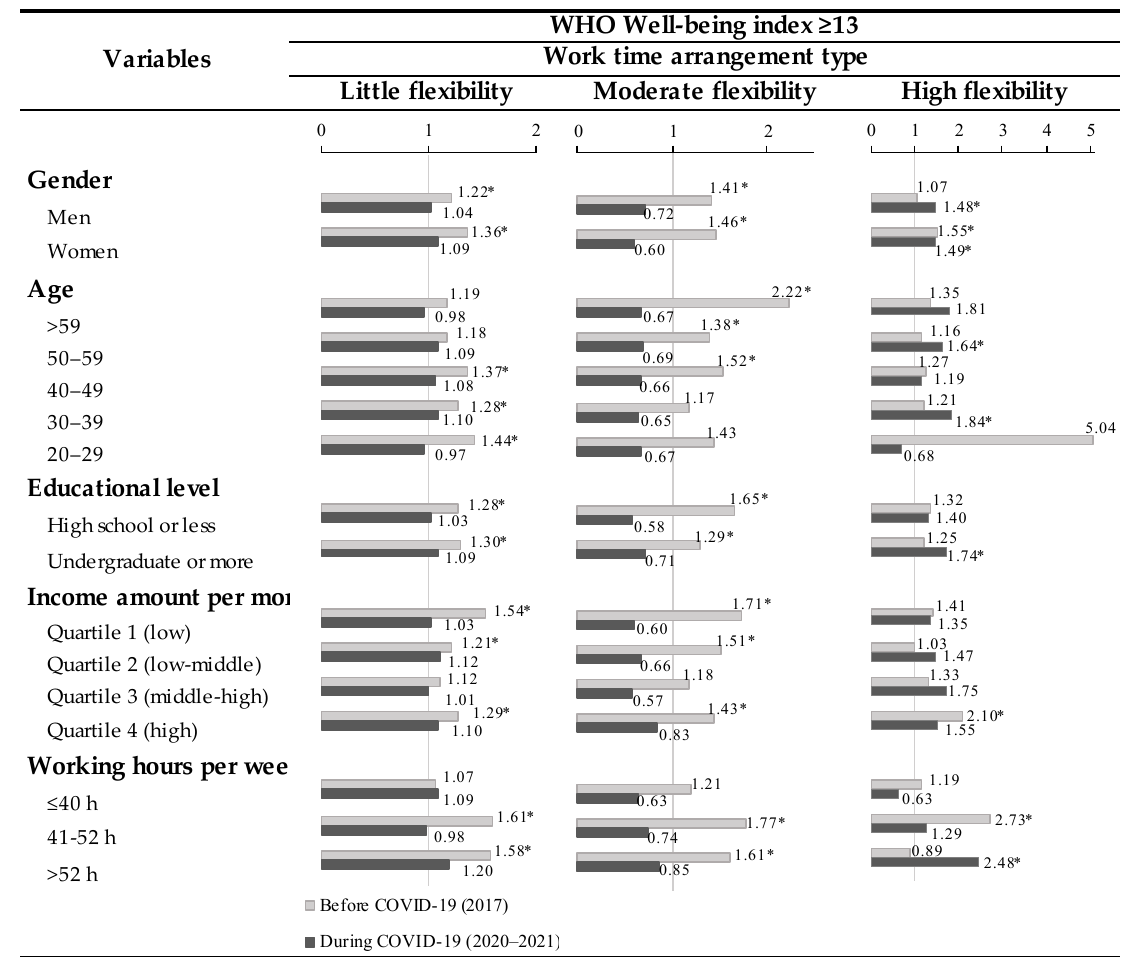
Figure 1. The results of subgroup analysis stratified by independent variables and year.